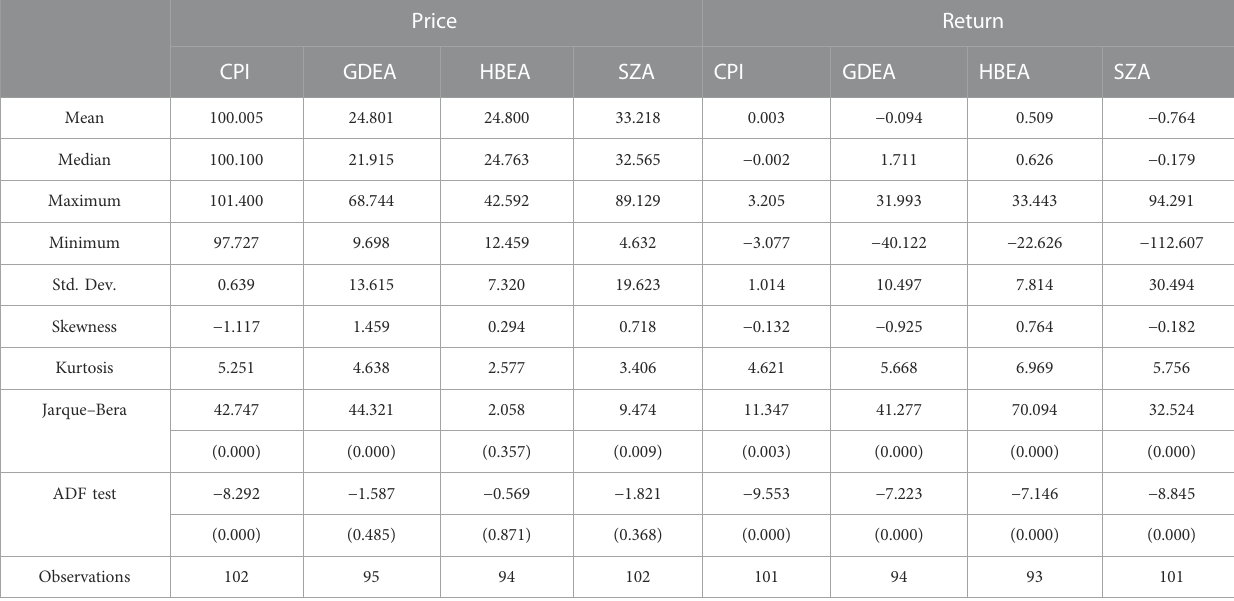
TABLE 1 Descriptive statistics of CPI and carbon prices.